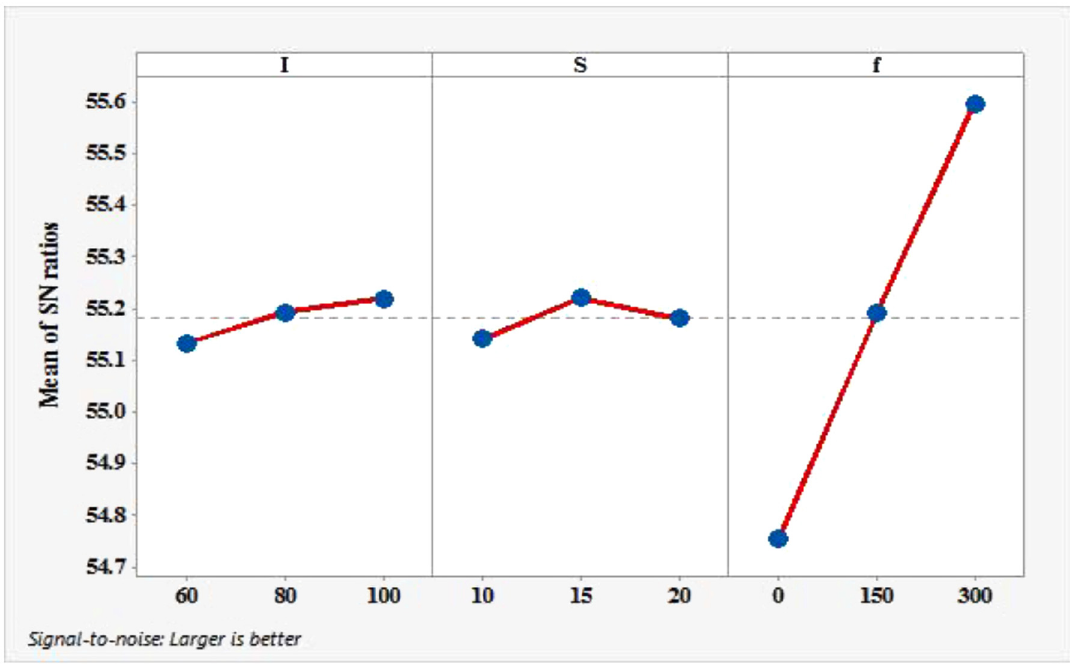
Fig. 5. Main effect plot of S/N ratio of UTS for L 9 OA.